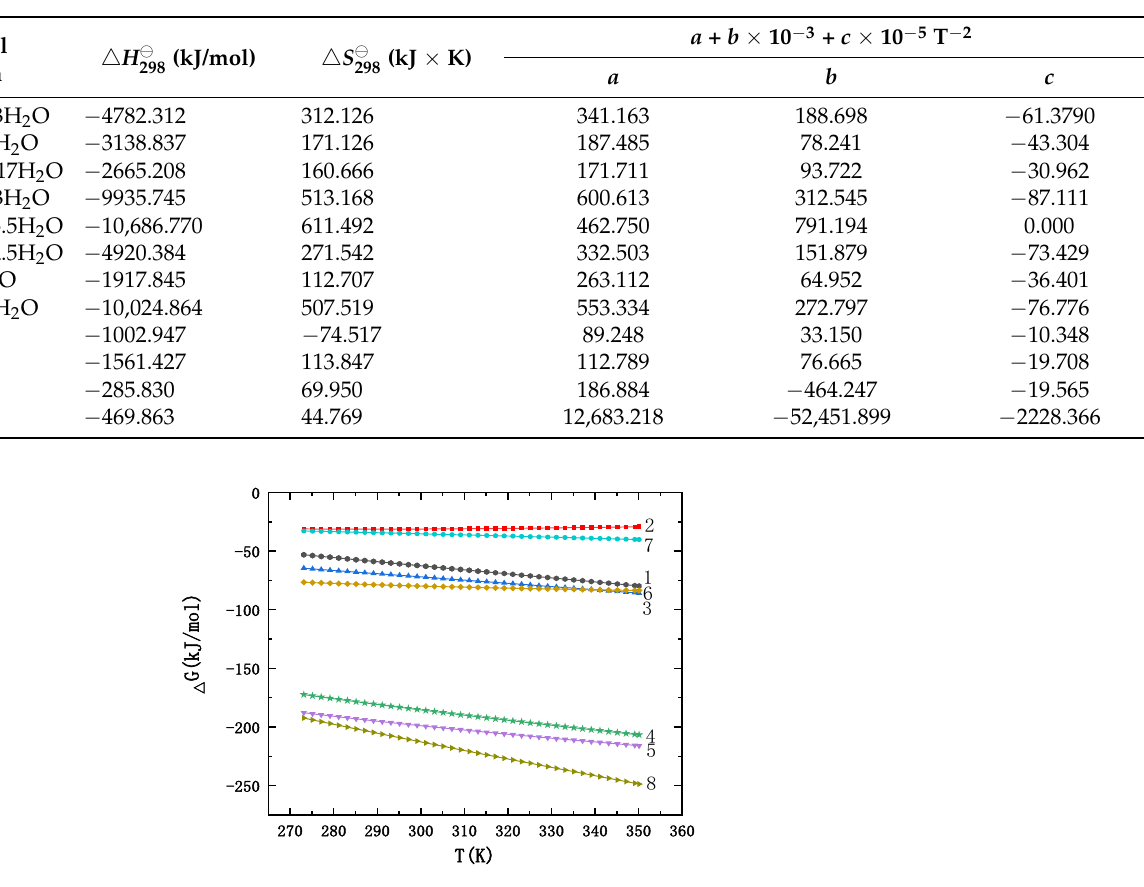
Table 4. The related thermodynamic parameters of the products and reactants.